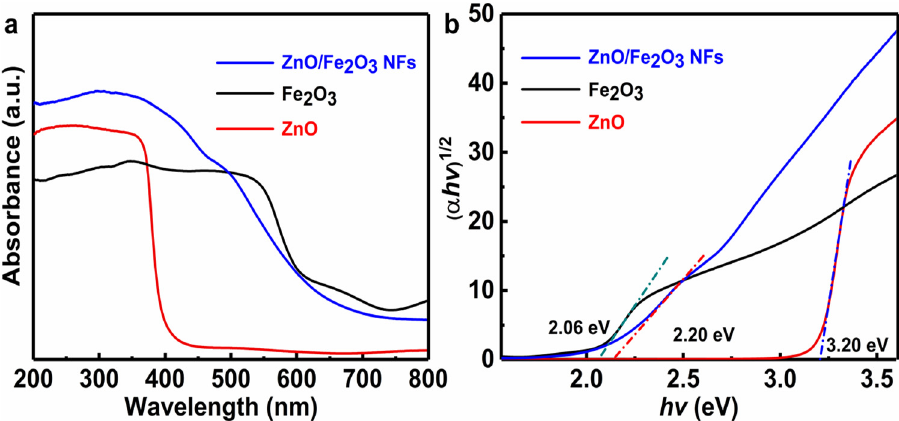
Figure 6. ( a ) UV-vis diffuse reflectance spectra and ( b ) Tauc plots of ZnO, Fe 2 O 3 , and ZnO/Fe 2 O 3